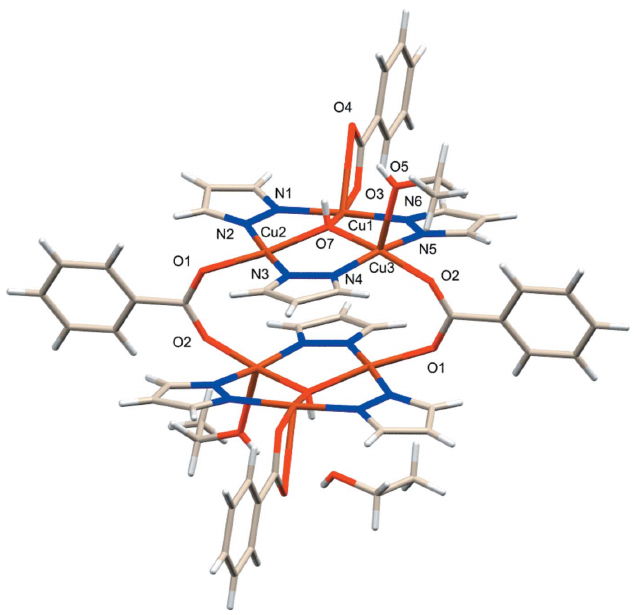
Figure 3 Dimeric-bridged molecular structure of the title compound with displacement ellipsoids drawn at the 50% probability level.